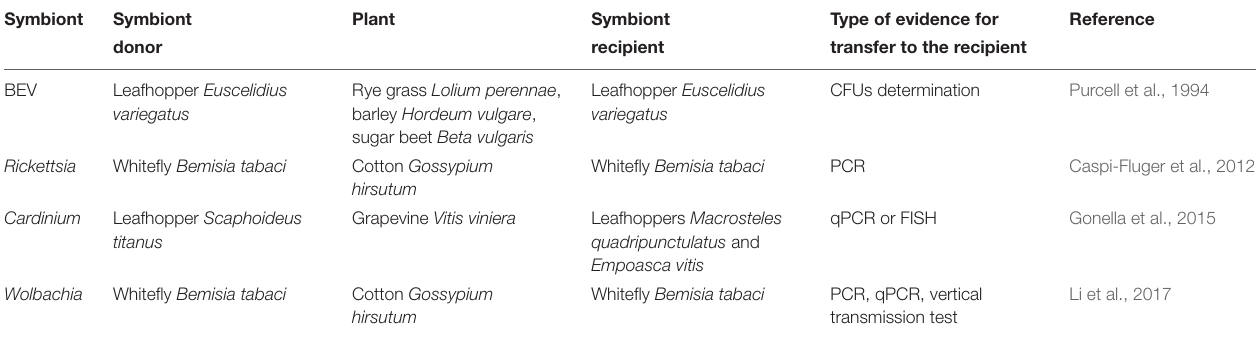
TABLE 1 | Summary of the literature on experimental plant-mediated horizontal symbiont